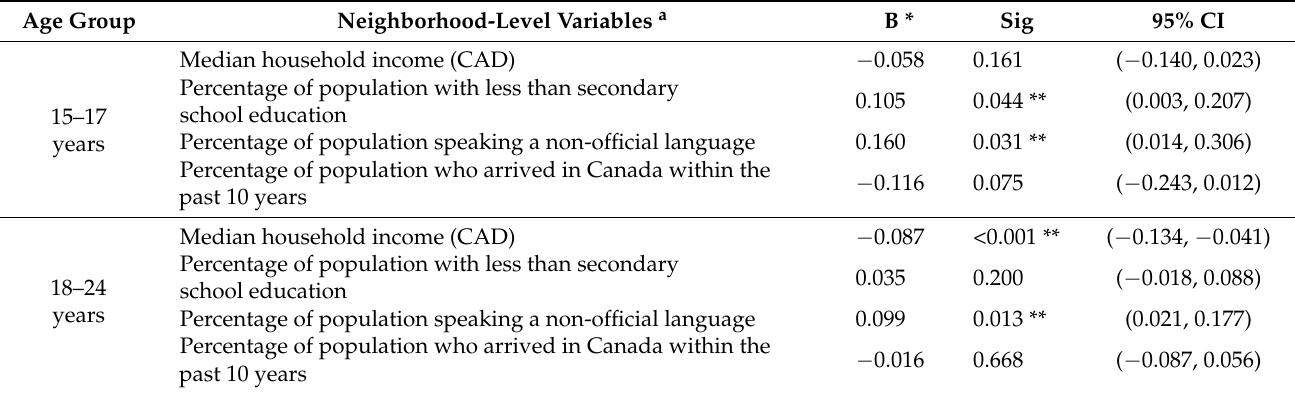
Table 5. The association of neighborhood-level demographic variables with cost of dental